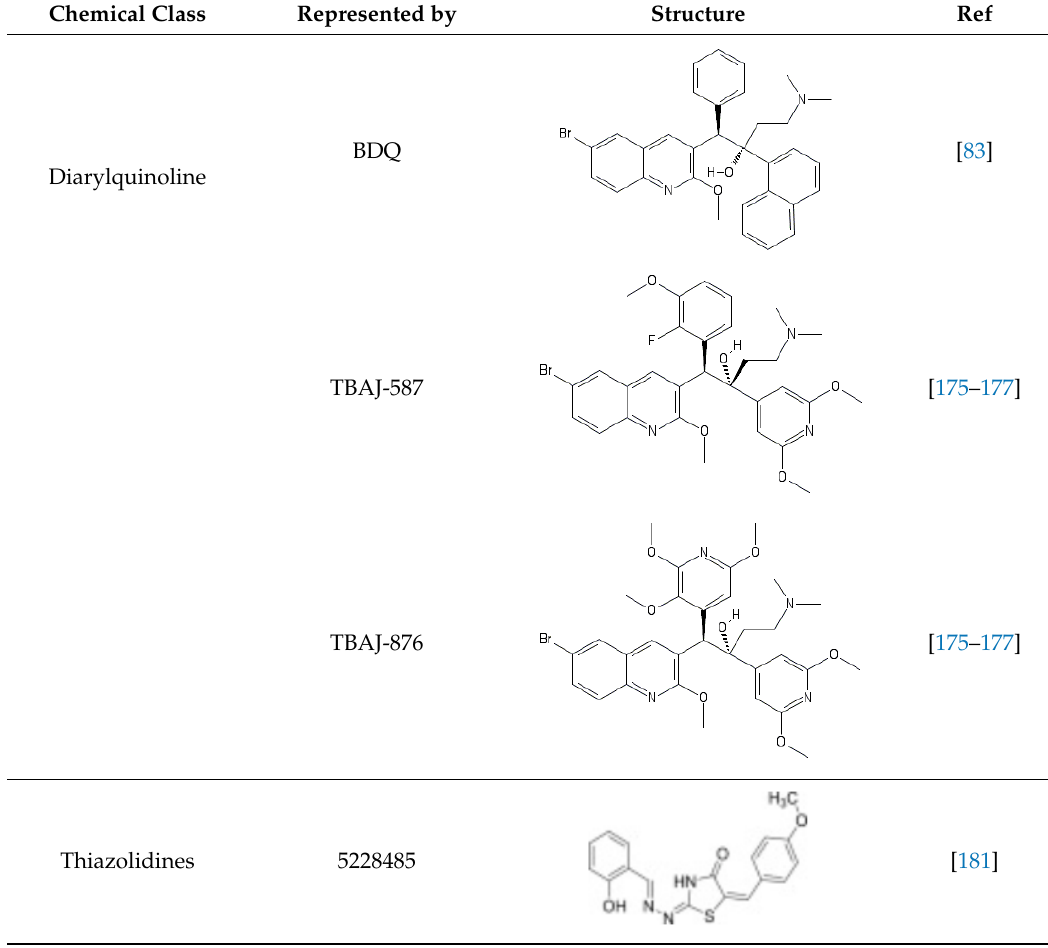
Table 4. Inhibitors of the ATP synthase discussed in this review.